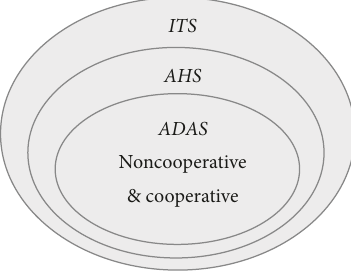
Figure 2: Schematic relations of ITS, AHS, and ADAS